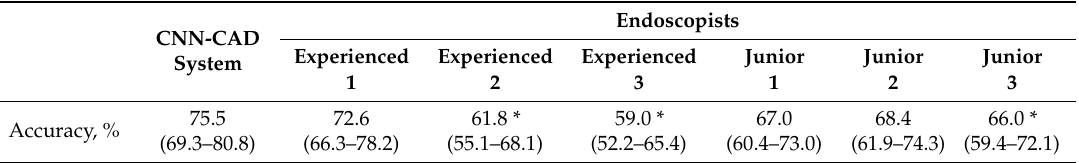
Figure 3. Flowchart of sequential convolutional neural network computer-aided detection system in the test dataset. Table 3. Overall diagnostic accuracy of gastric mesenchymal tumors by a convolutional neural network computer-aided detection system compared to that of